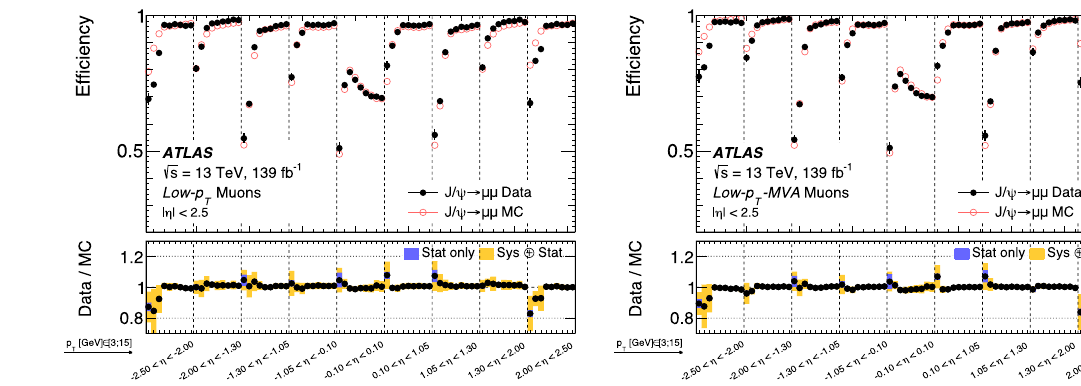
Fig. 16 Muon reconstruction and identificationefficiency measured in J /ψ → μμ events for the cut-based (left) and multivariate (right) Low - p T criteria. In the plots, within each η region, the efficiency is measured in nine p T bins (3–3.5, 3.5–4, 4–5, 5–6, 6–7, 7–8, 8–10, 10–12, 12– 15 GeV). The resulting values are plotted as distinct measurements in